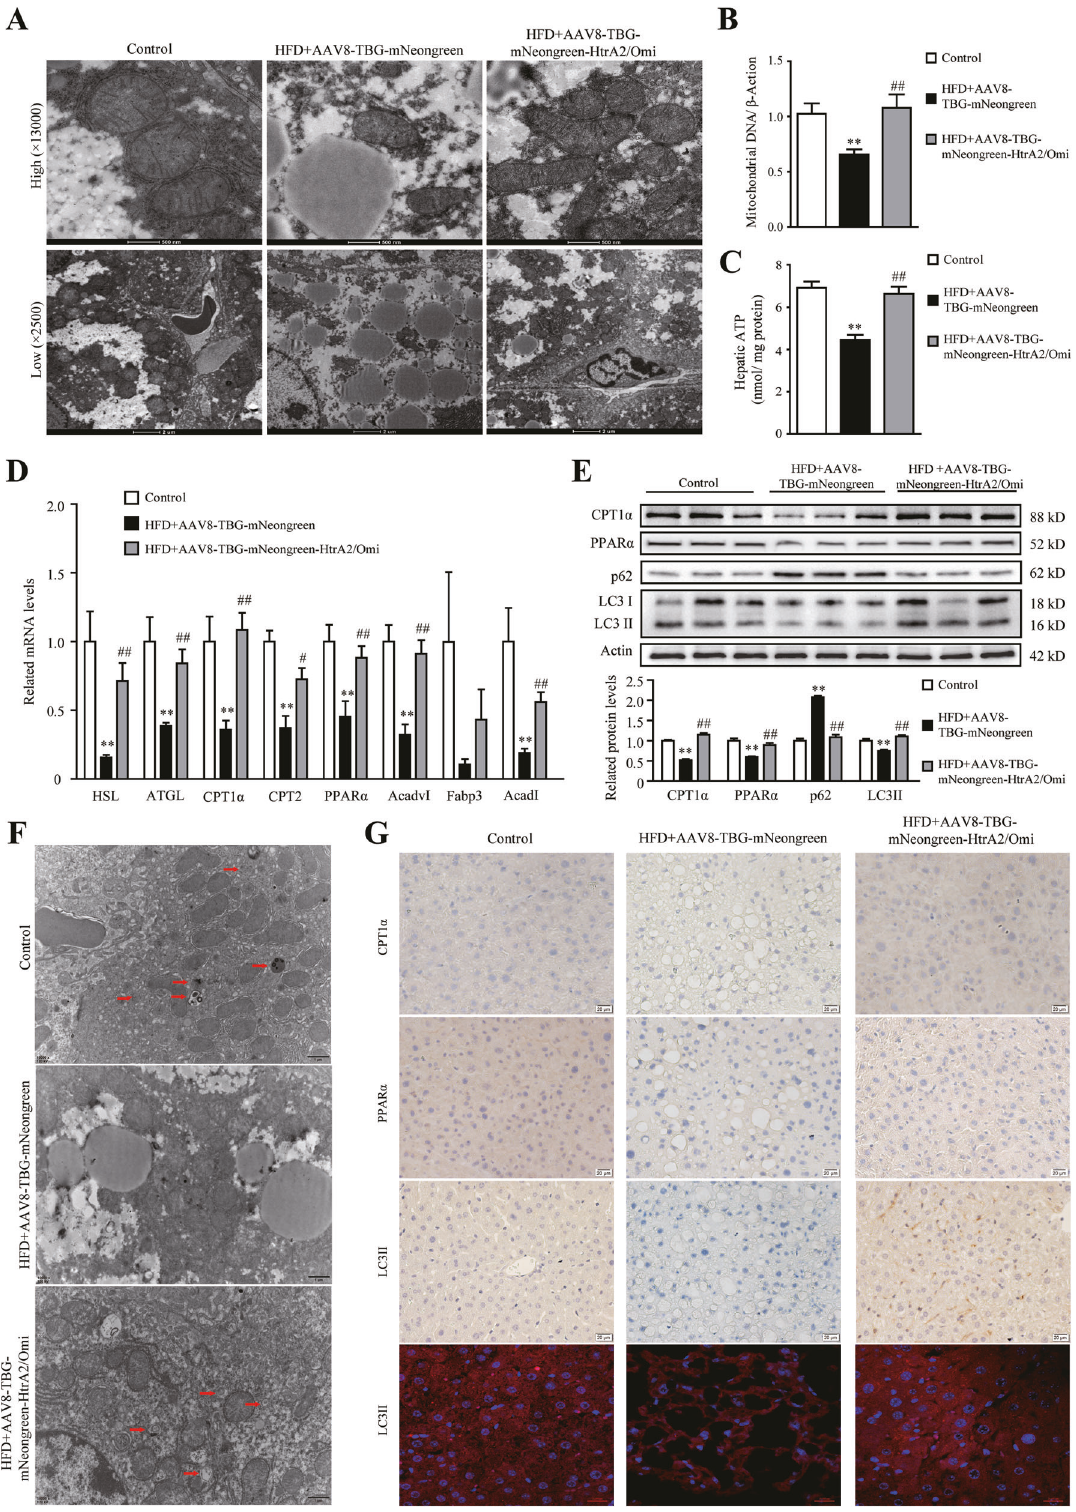
Fig. 3 Hepatic HtrA2/Omi expression protects against mitochondrial impairment and enhances autophagy activity in fatty liver. A Representative TEM images of hepatic mitochondria. Mitochondrial morphology and integrity were observed. Scale bar (up): 0.5 μ m; scale bar (down): 2 μ m ( n = 7). B Hepatic mtDNA content in different groups ( n = 7). C The levels of ATP in the liver ( n = 7). D The expression of genes involved in lipid metabolism in the livers ( n = 7). E Western blot analysis of CPT1 α , PPAR α , p62, and LC3I/II in liver tissues. The histogram shows the ratio quanti fi cation of band intensities ( n = 3). F Images from TEM show characteristic autophagosomes (red arrows) in hepatocytes. scale bar: 1 μ m ( n = 7). G Immunohistochemical staining of CPT1 α , PPAR α , and LC3II in the liver, scale bars: 20 μ m ( n = 6); immuno fl uorescence of LC3 puncta, scale bars: 10 μ m ( n = 6). Data are shown as means ± SEM. One-way ANOVA was used. ** P < 0.01 vs. control group; # P < 0.05 vs. HFD + AAV8-TBG-mNeongreen group; ## P < 0.01 vs. HFD + AAV8-TBG-mNeongreen group. Cell Death Discovery (2022)